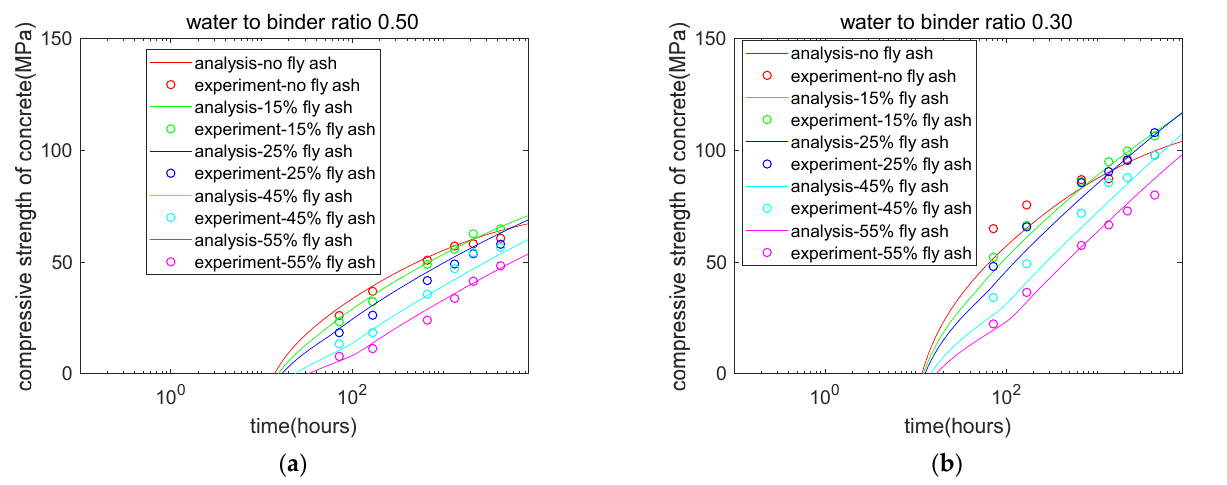
Figure 4. Parameter study of hydration-based strength model. ( a ) Development of compressive strength (W/B, 0.5). ( b ) Development of compressive strength (W/B, 0.3).